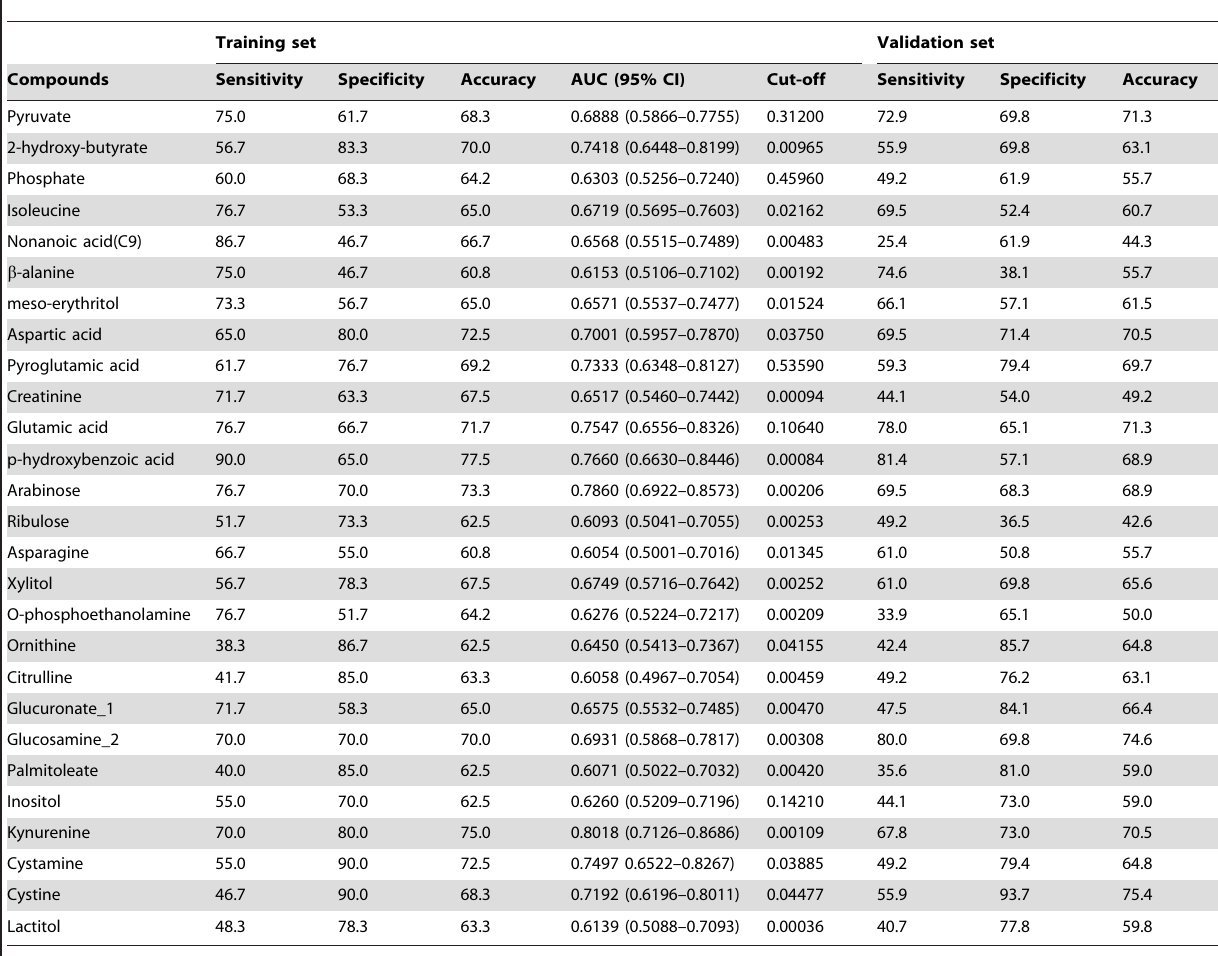
Table 2. The sensitivity and specificity of the metabolites whose levels differed significantly between the colorectal cancer patients and healthy